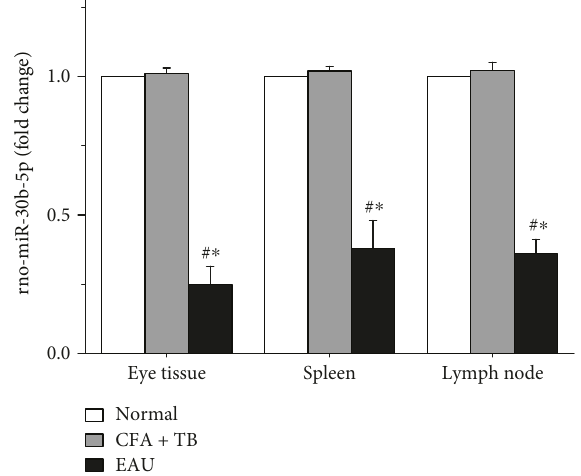
Figure 2: Expressions of rno-miR-30b-5p in spleen, lymph nodes, and eye tissues in EAU rats. # P < 0 05 compared with the normal control group. ∗ P < 0 05 compared with the CFA+ TB